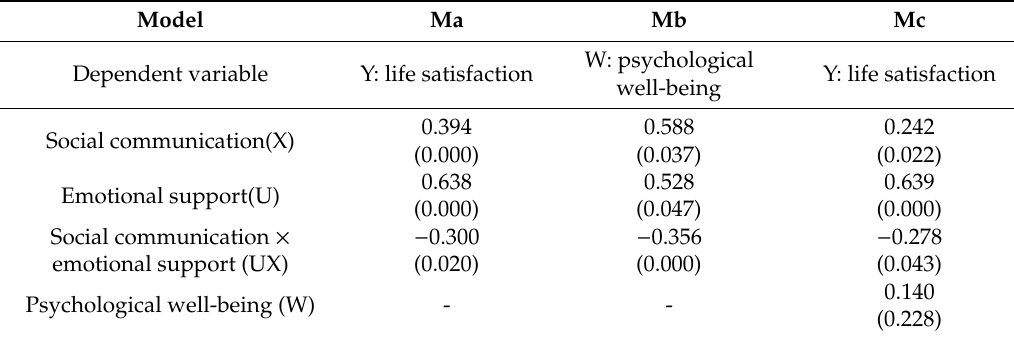
Table 3. The results of the mediating e ff ect and the moderating e ff ect.